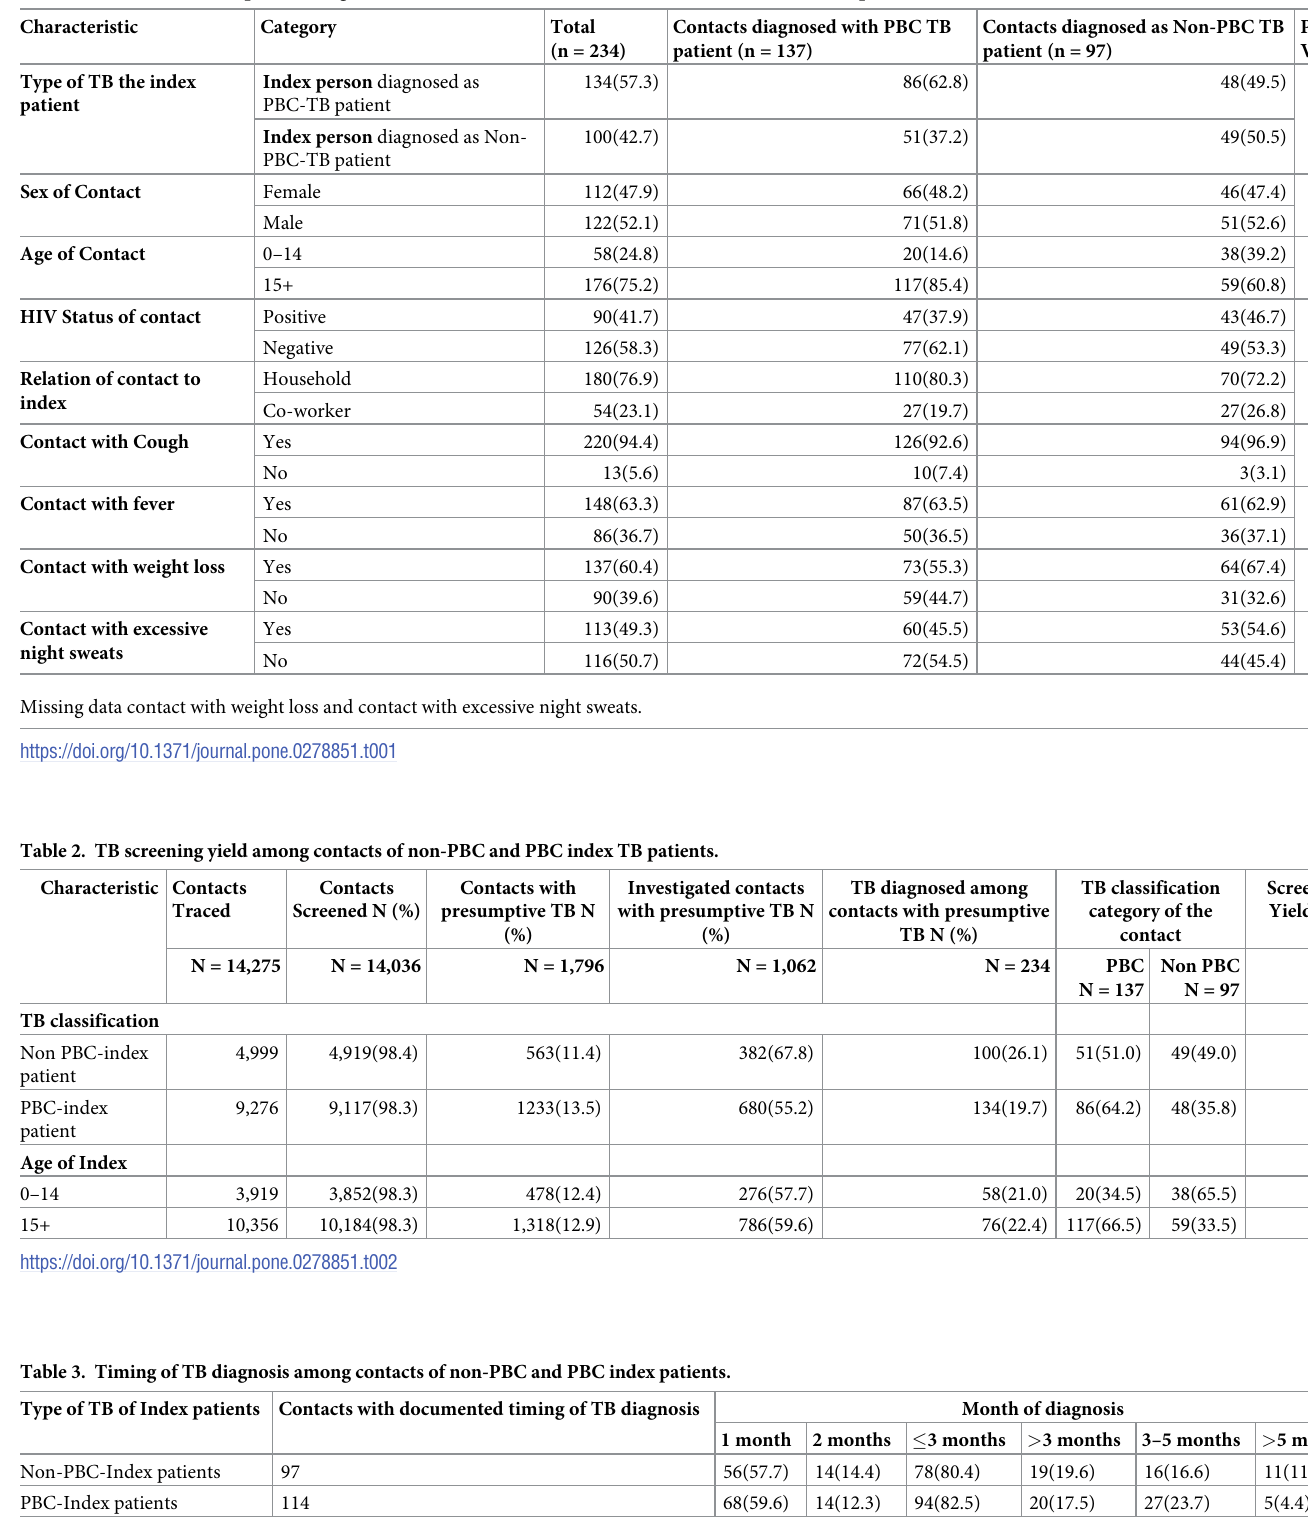
Table 1. Characteristics of persons diagnosed with TB who were contacts of non-PBC and PBC index patients.